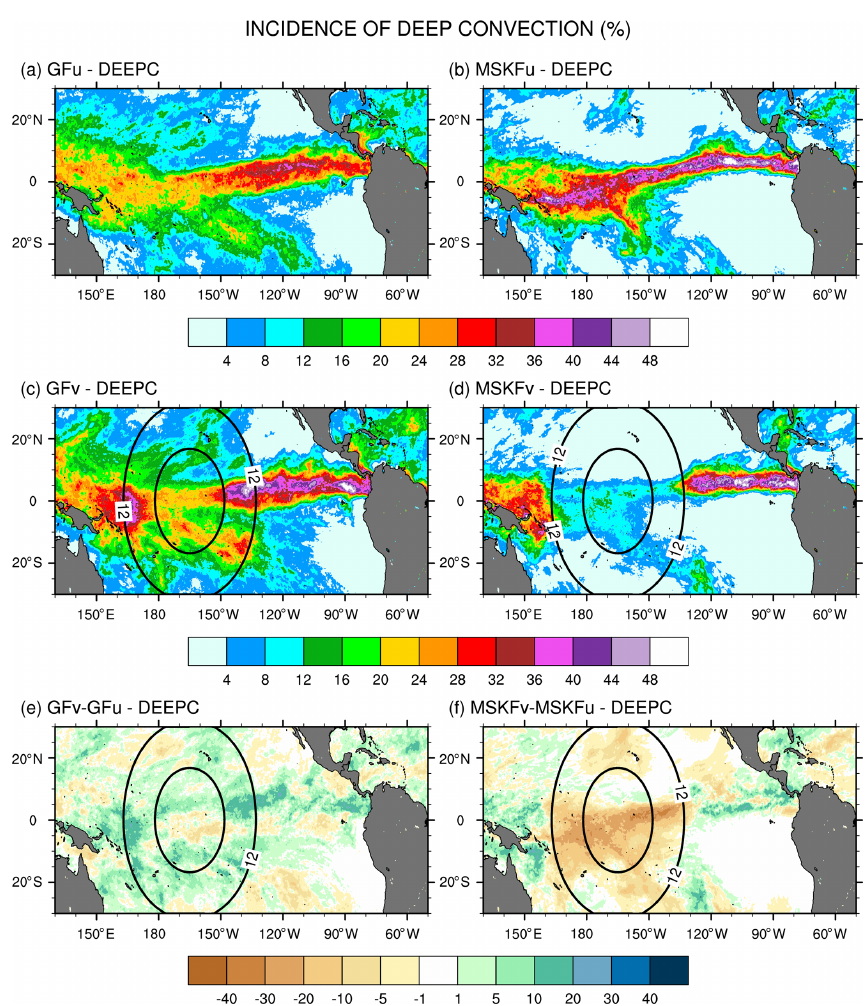
Figure 7. As Fig. 6 but for the monthly-mean incidence of deep convection